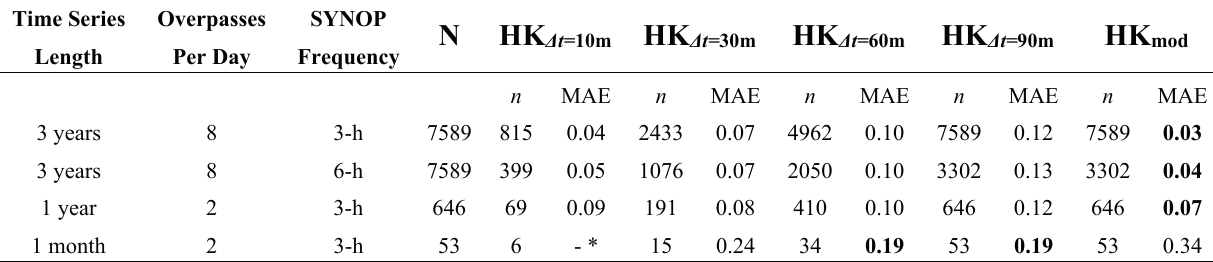
Table 3. The mean absolute bias (MAE) in the Hanssen-Kuiper’s discriminant measured against the unbiased skill score (HK 0 ) at 10 BSRN sites depending on SYNOP observations frequency, time series length, and number of satellite overpasses per day. The validation methods are: four using different maximum time differences between the satellite observation (HK mod ). The values highlighted in bold font indicate the best performance. N gives the number of satellite observations per station, and n gives the number used for the validation depending on the validation